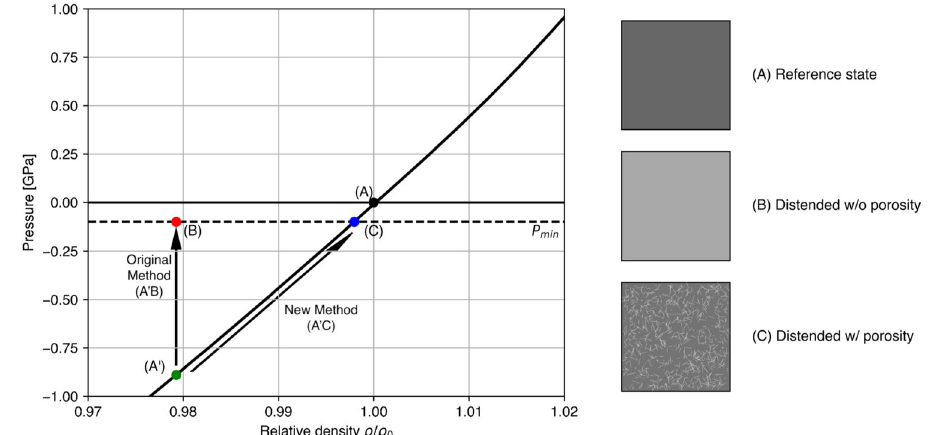
Fig.5|Thetensileporosityalgorithm. Materialoriginallyatthereferencestate( a ; solid (and bulk) density is left unchanged, whilst the (negative) pressure is capped ρ ρ = ρ at P min ( b ).Inthenewtensileporositymethod,thedensityofthesolidisadjustedto ρ 0 <1 (A'), for which the negative pressure pre- 0 ) goes into a distended state, dicted by the equation of state (solid black line) for the material is below the beconsistentwiththeminimumpressure P min ( c )andporosity(~2%intheexample shown) is inserted to fi ll the remaining volume of the cell and ensure mass minimumpressurepermittedbythestrengthmodel, P min (dashedline;shownhere as 0.1GPa for illustration). The physical state of such a material is a distended, fractured rock mass. In the original iSALE algorithm, no porosity is added and the